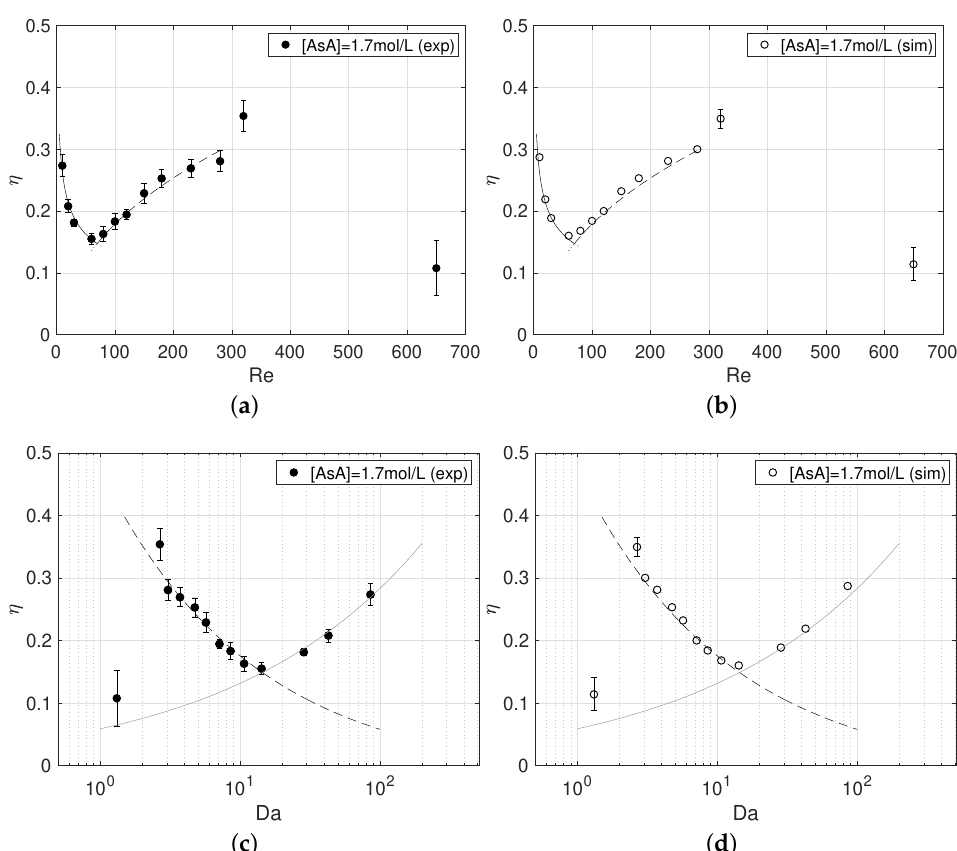
Figure 8. Reaction yield at Y = − 25 in experiments ( a , c ) and numerical simulations ( b , d ) as a function of Reynolds number ( a , b ) and Damköhler number ( c , d